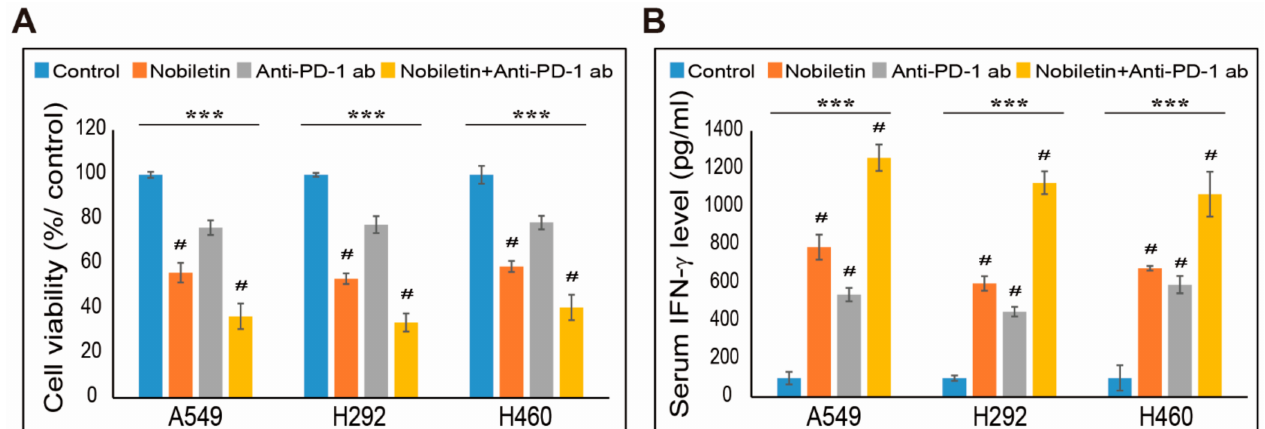
Figure 7. Nobiletin exhibits a combination effect with anti-PD-1 mAb in an NSCLC–PBMC co-culture system. ( A ) Cell survival analysis of NSCLC cells A549, H292, and H460 co-cultured with PBMCs were examined after treatment with 200 µ M nobiletin, anti-PD-1 mAb (5 µ g/mL), or both nobiletin and anti-PD-1 mAb for 48 h. *** p < 0.001 (ANOVA); # p < 0.001 vs. control. ( B ) Analysis of IFN- γ release from the co-culture system were determined by ELISA after treatment with 200 µ